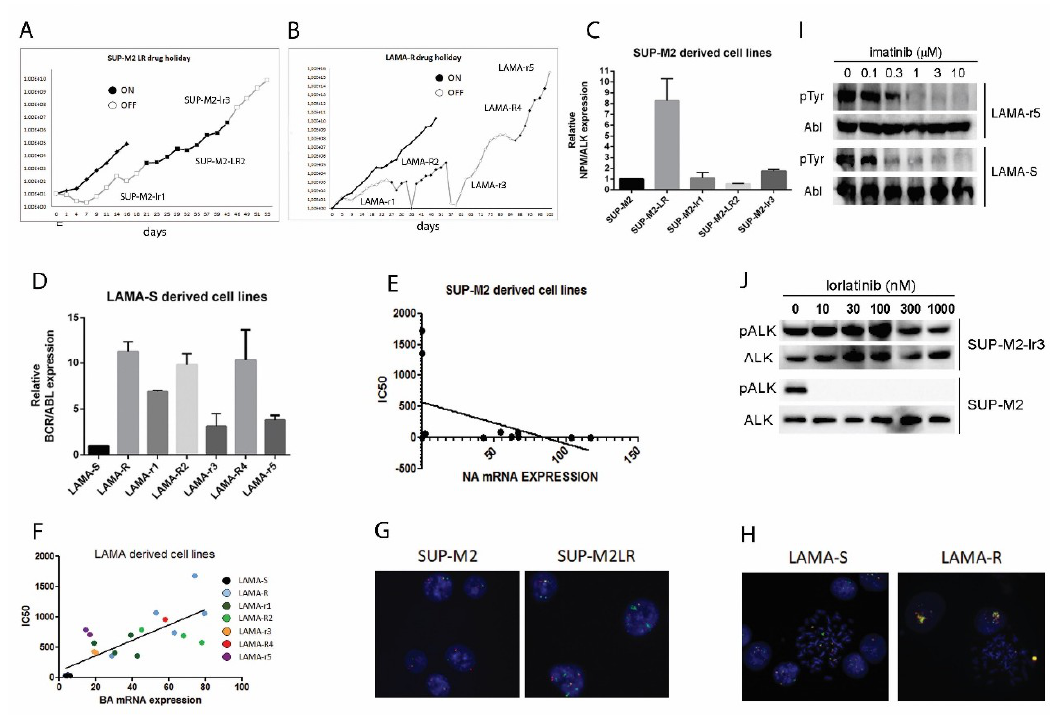
Figure 1. Drug holiday schedule is an effective strategy to keep tumor growth under control in vitro. ( A ) SUP-M2-LR cells or ( B ) LAMA-R cells were kept in culture in the absence of drug. When cells started growing again, specific drug was re-introduced in the medium at the same dose they were used to live before. Again, as soon as new selection occurs, drug was removed again and so on, until no drop in cell count or viability was observed. At each step a new cell line was established and characterized. White dots: cell count in the absence of drug. Black dots: cell count in the presence of drug. ( C ) NPM-ALK expression in SUP-M2 derived cell lines or ( D ) BCR-ABL mRNA expression in LAMA-S derived cell lines. Values of oncogene expression normalized on GUS expression ( ∆ Ct method) are shown. Each dot represents a single PCR reaction normalized on the average of GUS expression values detected in the same experiment. ( E ) correlation between IC50 value and oncogene transcription level in SUP-M2 derived cell lines or ( F ) LAMA derived cell lines. ( G ) Panels representative of the interphase FISH analysis on SUP-M2LR compared to SUP-M2 cell lines or ( H ) LAMA-R compared to LAMA-S. Magnification: 63 × . ( I ) LAMA-r5 or ( J ) SUP-M2-lr3 cell lines were challenged with the indicated doses of inhibitor. Corresponding oncogene activity was assessed by western blot.